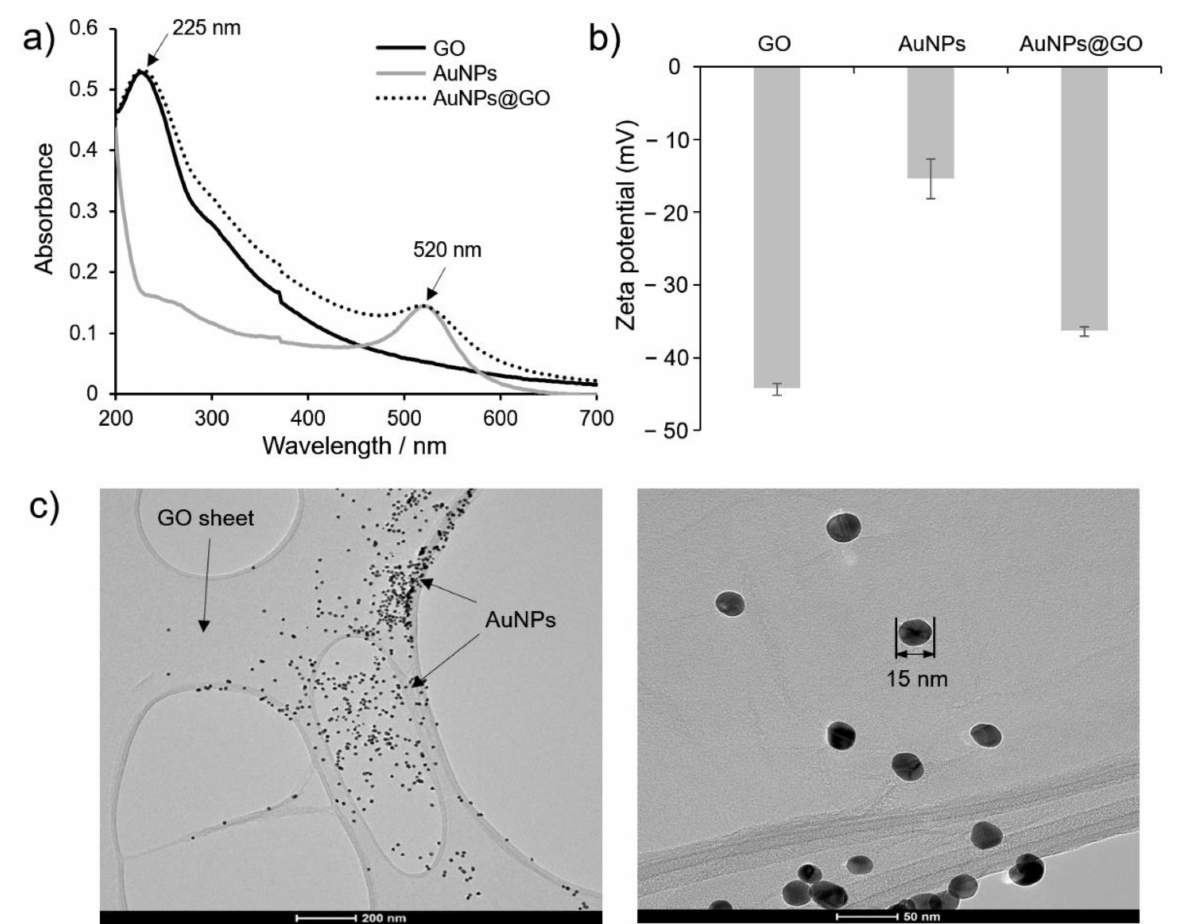
Figure 1. Characterization of the prepared AuNPs@GO nanocomposite. ( a ) UV-vis spectra and ( b ) zeta potentials of graphene oxide (GO), gold nanoparticles (AuNPs), and GO–AuNPs (AuNPs@GO) nanocomposite, and ( c ) transmission electron microscopy images of AuNPs@GO